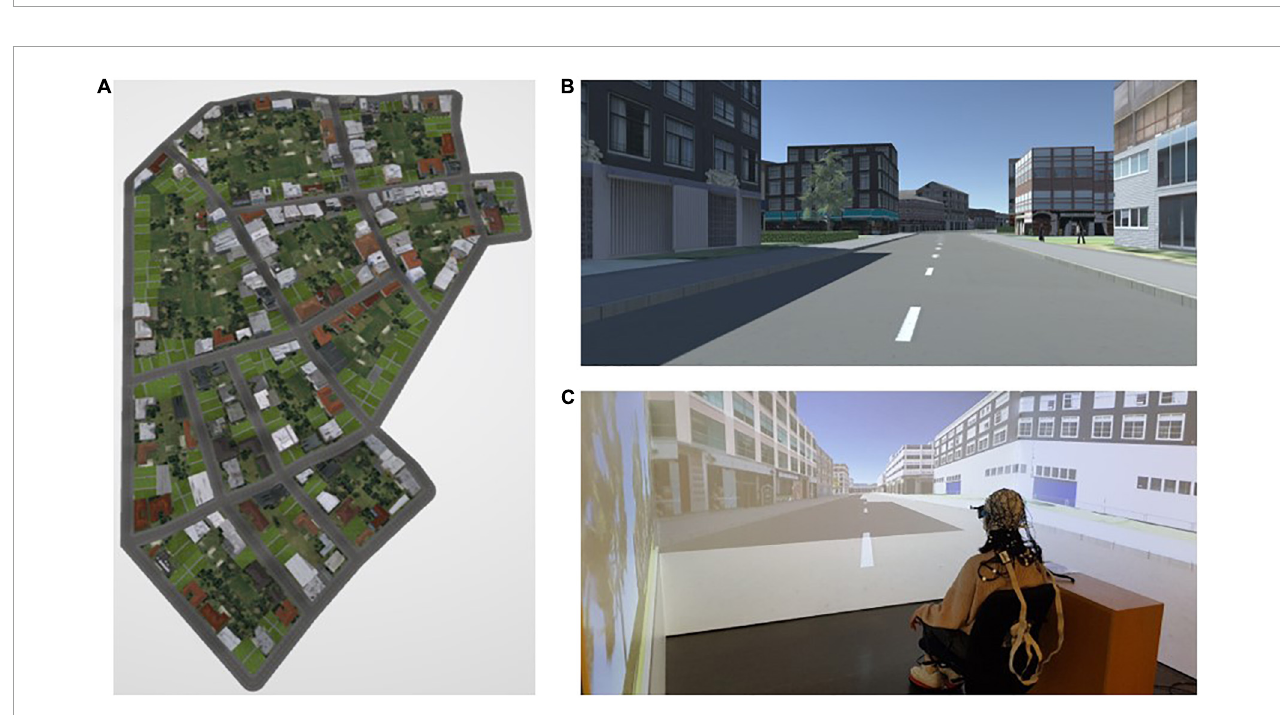
FIGURE4 (A) Bird’s eye view of one of the virtual cities; (B) participants’ view of the environment during navigation; and (C) a participant seated on a chair approx. 30 cm away from the center of the VR system (CAVE), placed her feet on a foot-operated controller, and was equipped with an EEG device during the navigation experiment. The figure is adapted from Cheng et al.